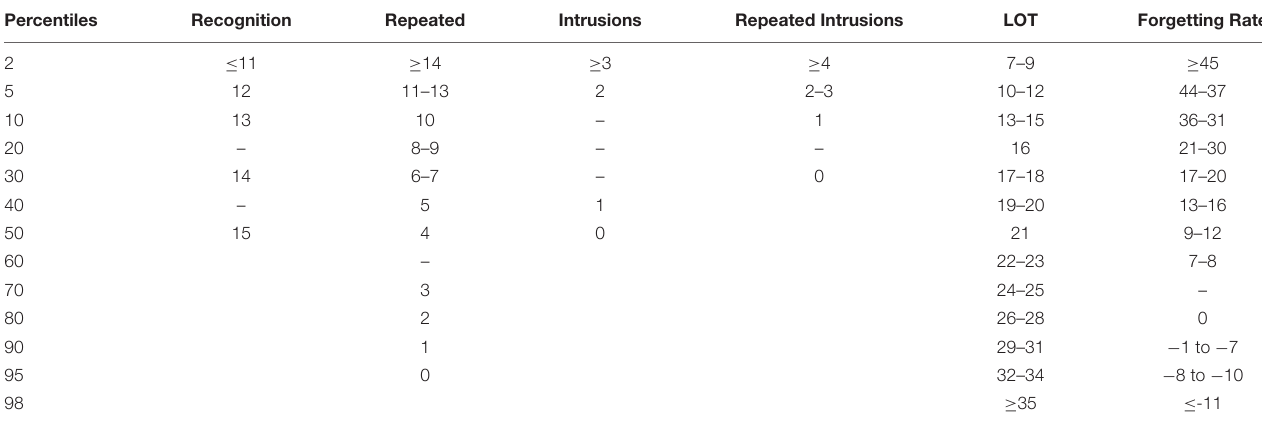
TABLE 10 | Normative data for Recognition, Errors, Learning Over Trial (LOT), and Forgetting Rate on RAVLT.